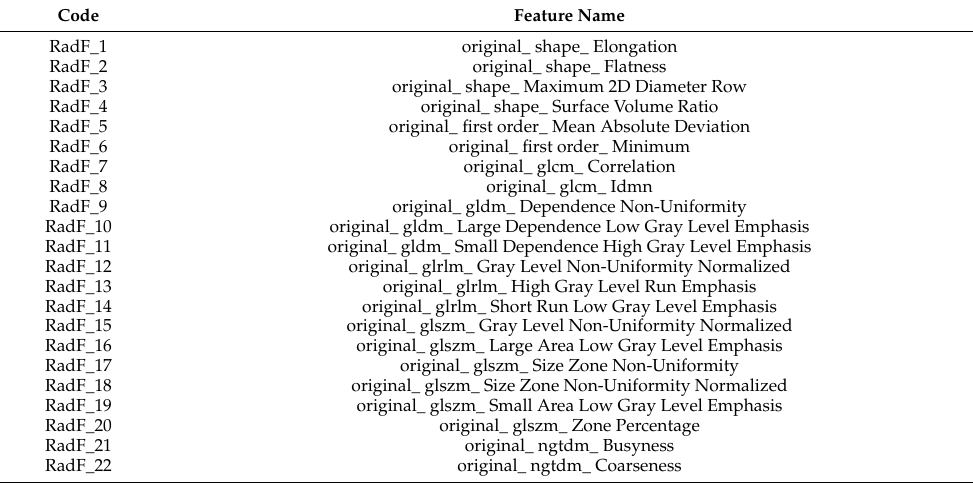
Table 3. Radiomics characteristic codes and their corresponding names.